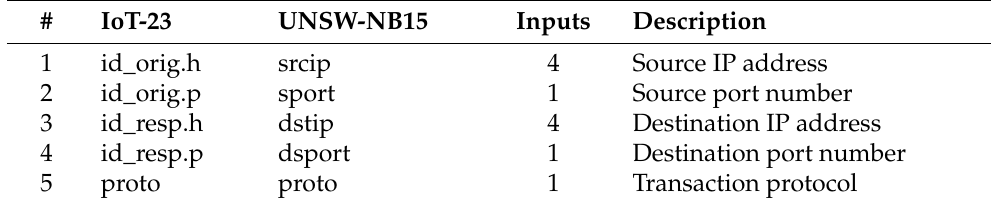
Table 5. Flow Features from the IoT-23 and UNSW-NB15